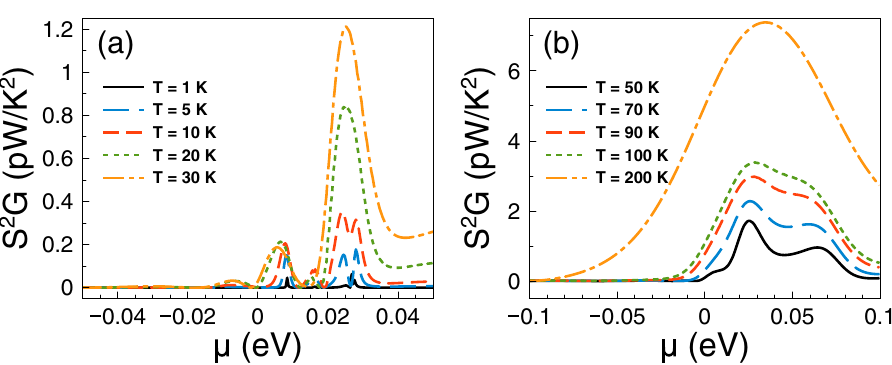
factor. In fact, the conductance increases significantly at the energy region in which hybrid resonances become preponderant. In the case of ZT we find multiple peaks associated to the charge neutrality point, Breit–Wigner and hybrid resonances as shown in Fig. 19. At low temperatures, up to 30 K, the peak related to Breit–Wigner resonances dominates ZT reaching a maximum of 3.5 at 20 K. The peak associated to hybrid resonances becomes dominant at 50 K, reaching a ZT value of 1. For higher temperature the leading peaks merge as a single one that